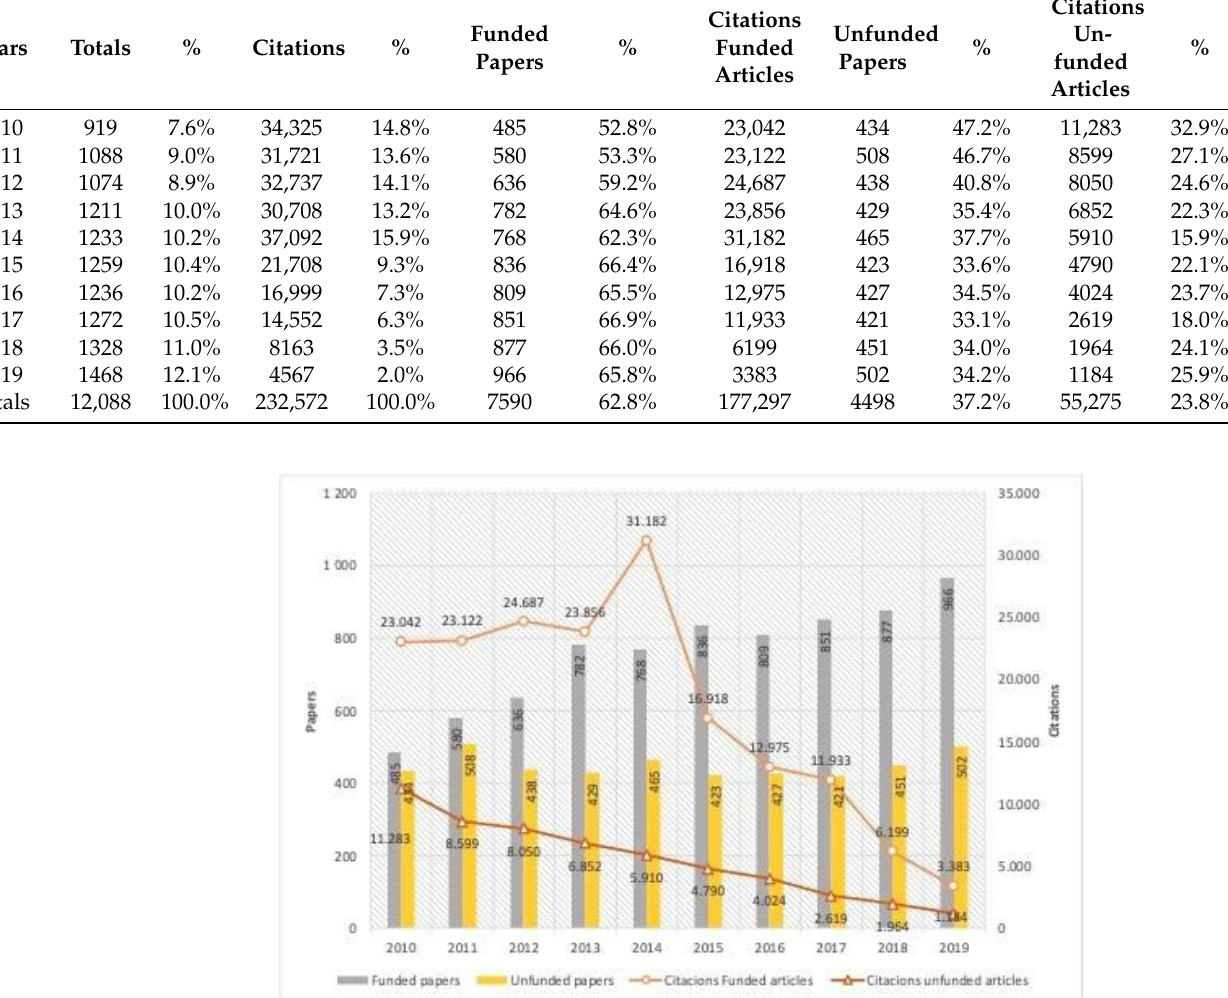
Figure 1. Annual evolution of funded and unfunded published papers and citations.